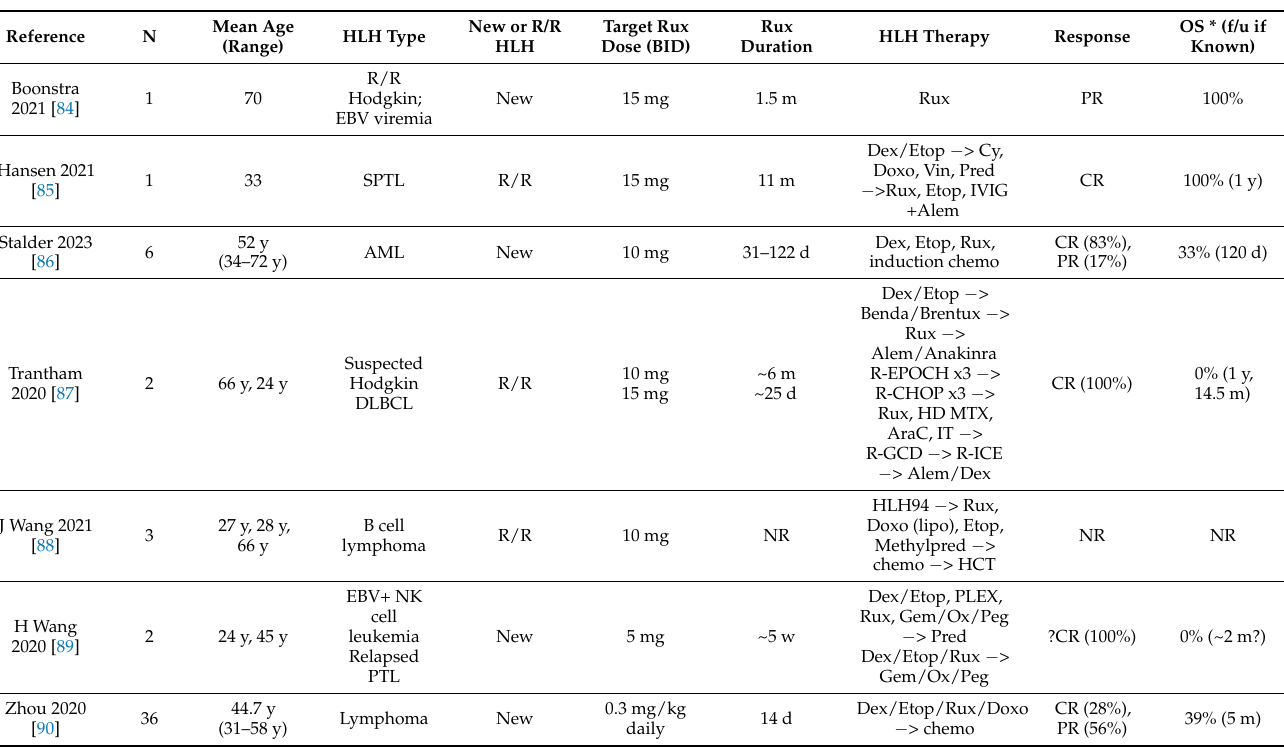
Table 3. Publications on Ruxolitinib for the Treatment of Adults with